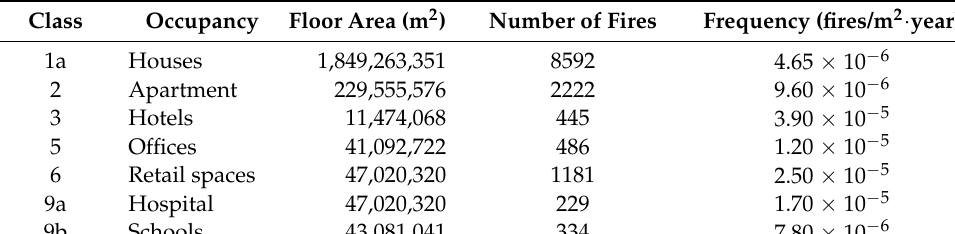
Table 4. Statistical data for ignition frequency of structural fires in Australia from 2012 to 2019 from the Australian Bureau of Statistics and the Department of Climate Change and Energy Efficiency [20].